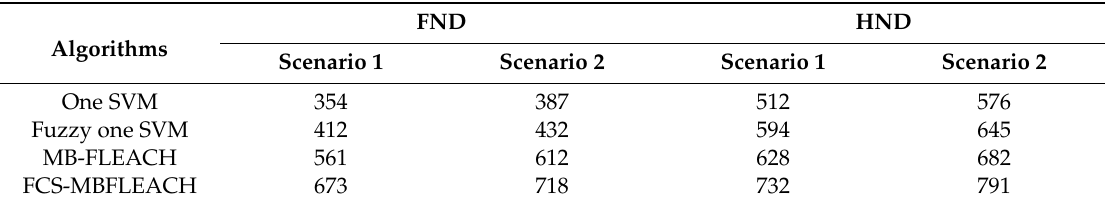
Table 4. A comparison between the proposed algorithms in terms of remaining energy, as well as FND and HND criteria.